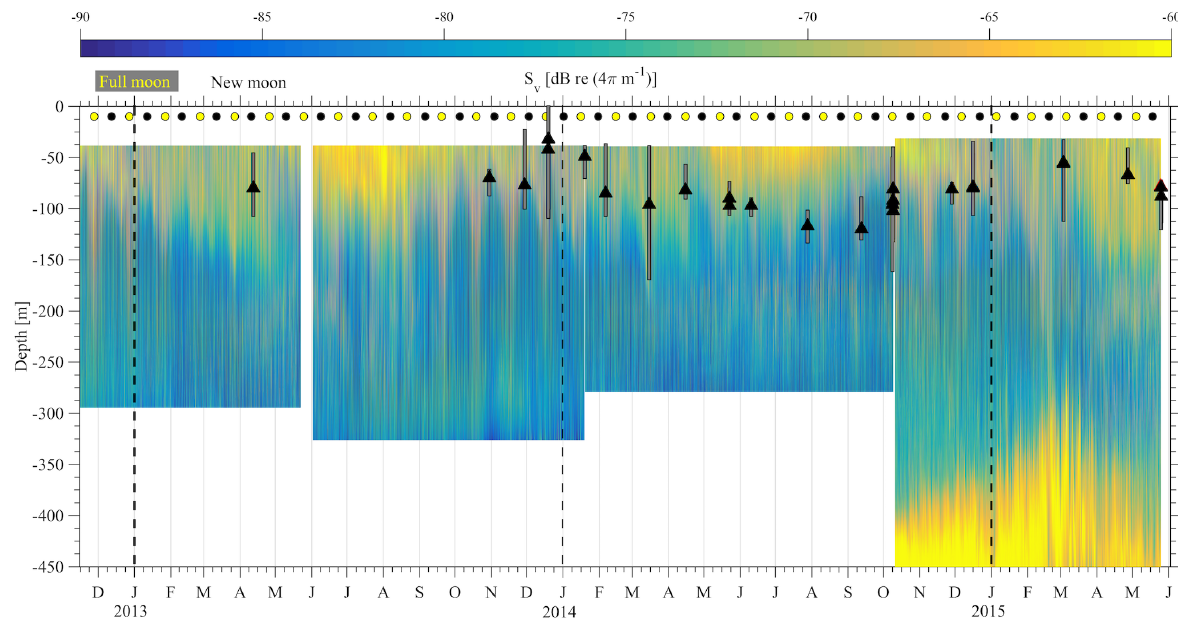
Figure 6. The backscatter coefficient for all ADCP deployments is shown. The beginning of a year is denoted by a dashed vertical line. The yellow and black circles denote the dates of the full and new moons, respectively. The maximum chlorophyll value of available casts is denoted by the black triangle. The gray bars around the triangles represent the depth range for which the chlorophyll concentration is above 70% of the maximum value of the cast.